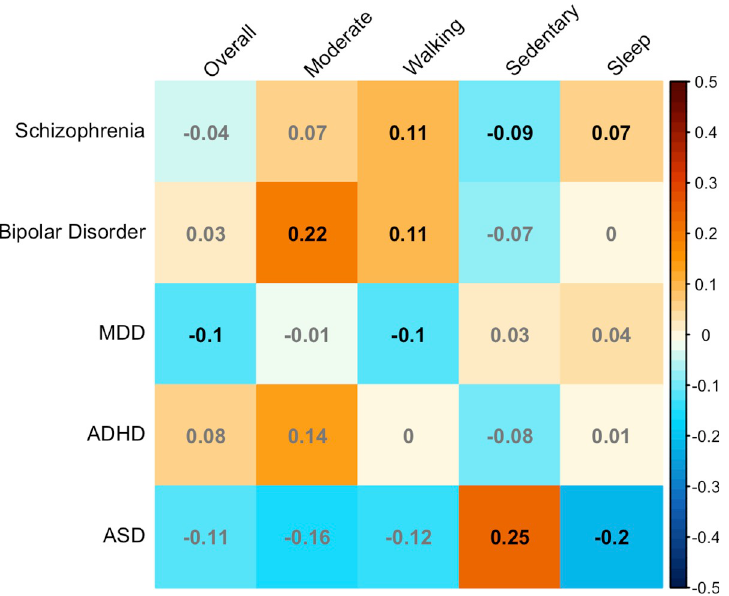
Fig 3. Genetic correlation matrix displaying the correlation coefficient (r g ), with square colour indicating direction of effect. Black text indicates correlation coefficients significant at FDR-corrected p < .05, grey text indicates non-significant